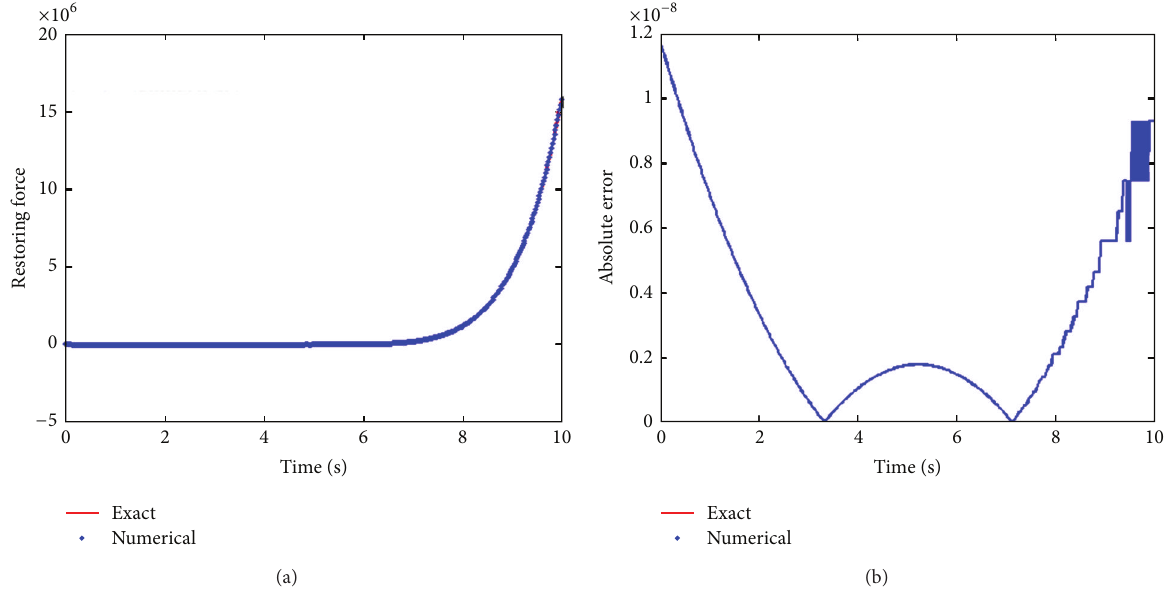
Figure 9: For Example 2, (a) comparing exact solution and numerical one for restoring force with 𝑇 0 = 4×10 5 and 𝑚 = 500 under 10 seconds and (b) displaying the estimated error of restoring force.